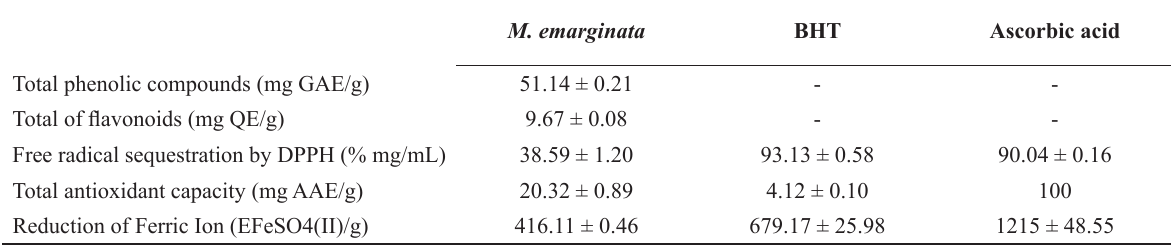
Result of antioxidant activities and phenol amounts found on saline extract from M. emarginata leaves.